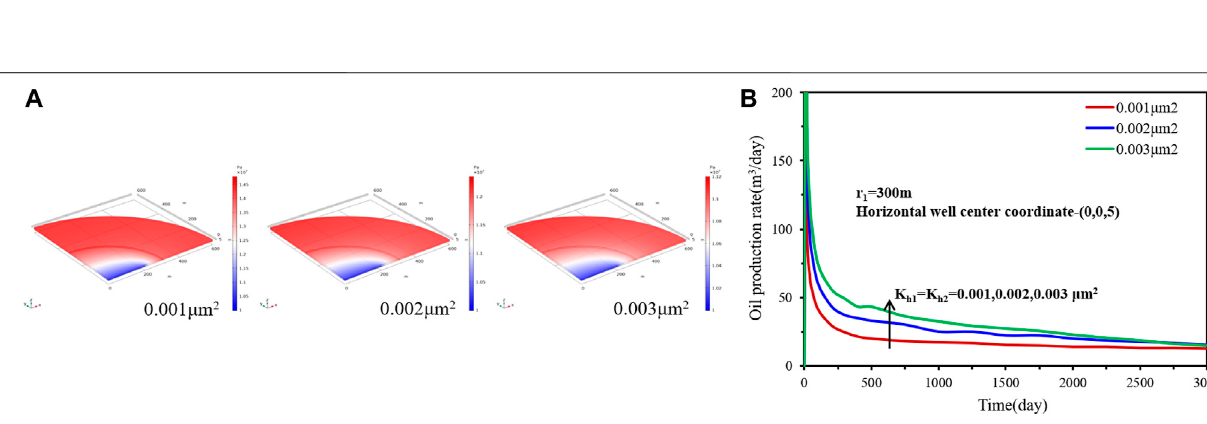
FIGURE 5 | Effect of inner region permeability on (A) transient pressure and (B) rate decline performance.